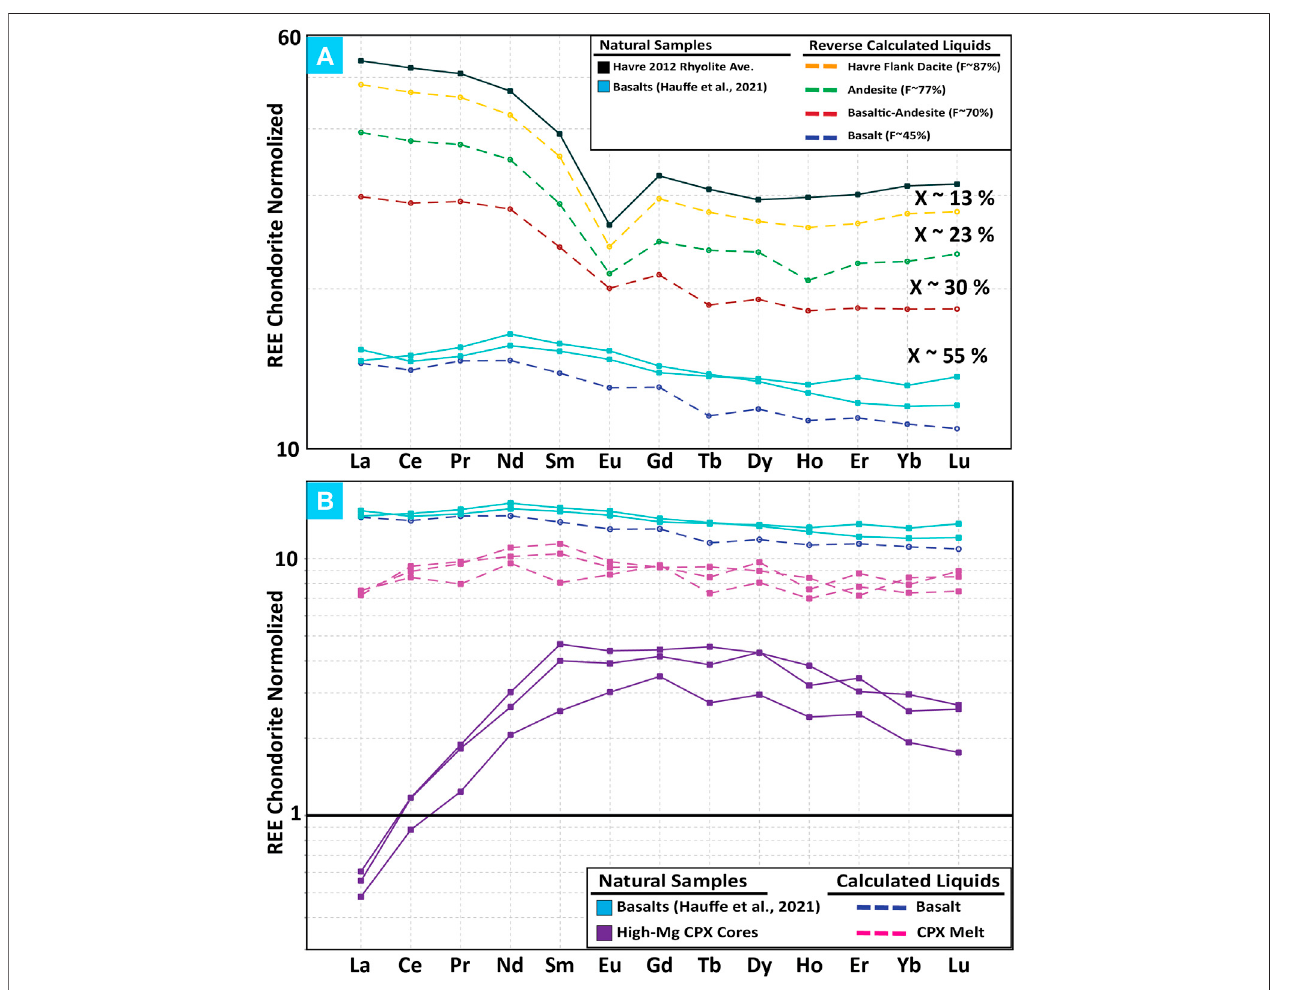
FIGURE 8 | Rare earth element (REE) reverse-calculated crystal fractionation models. (A) Reverse-calculated REE plots generated by reverse crystal fractionation modelingfromanaverageHavre2012rhyolitetraceelementpattern(blacksolidline).LiquidsforeachcalculatedREEpattern(dashedlines)aregeneratedbyutilizingthe mineral assemblage and proportions of each phase calculated in rhyolite-MELTS models incrementally from Havre 2012 rhyolite to Havre fl ank dacite to andesite to basalticandesitetobasaltcompositions( Table3 ).ThepercentofcrystallizationcalculatedineachstepofthemodelsisdenotedbyX%,andtheREEpatternsthen correspond to the liquid (F) remaining for each rhyolite-MELTS modeling step. The resulting basalt calculated REE pattern is then compared to arc basalts from the regional data set (solid light blue lines; Hauff et al., 2021). (B) Calculated basaltic melt REE pattern (pink dashed lines) compared to the REE patterns of regional basalts andreverse-calculatedbasaltfromthepanel.ThemagnesiumaugitecoreREEpatterns(solidpurplelines)areutilizedtocalculatetheREEpatterns(dashedpinklines)of a basaltic melt; these magnesian augites would have crystallized from based on calculations from Sun and Liang (2012). All REE plots are normalized to chondrite (McDonough & Sun, 1985).